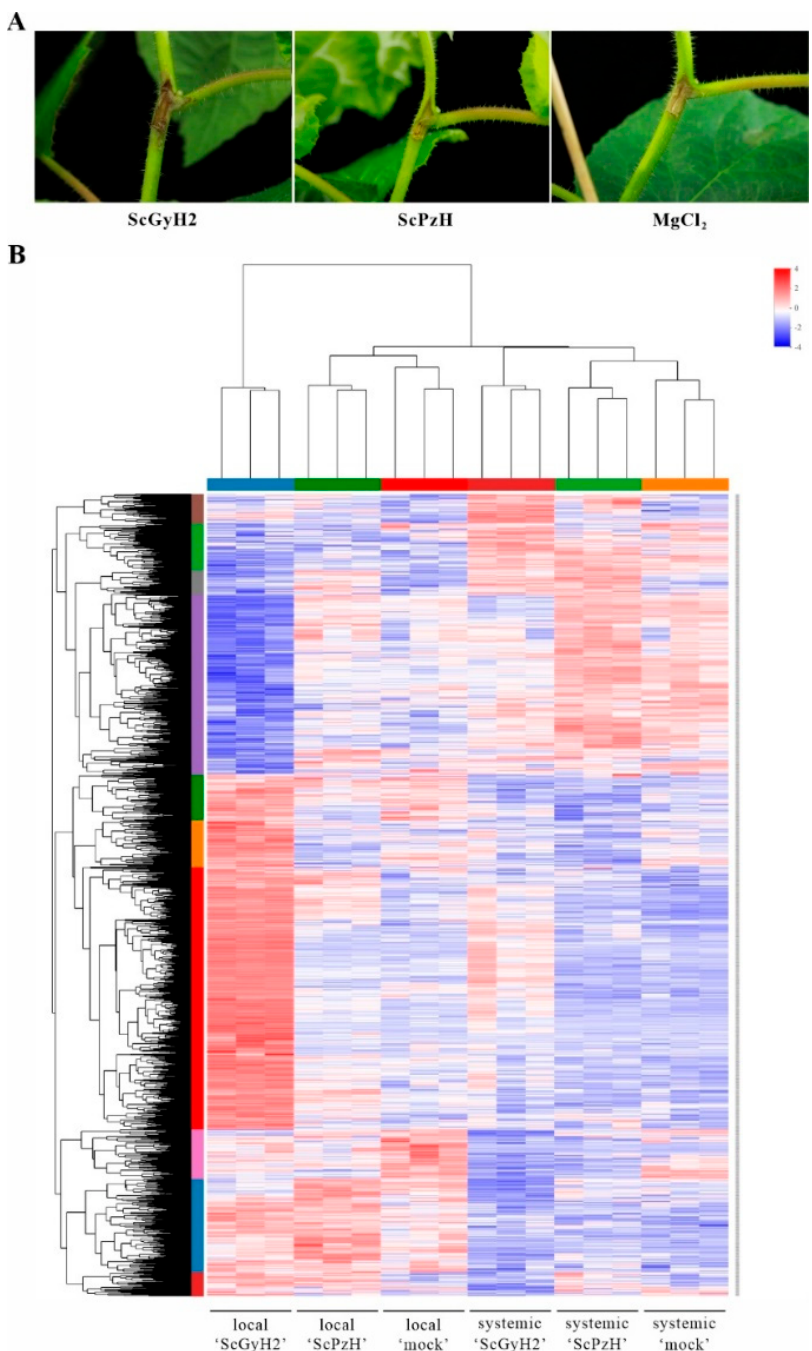
Figure 4. Transcriptomic responses of ‘Hongyang’ to the Psa strains ScPzH and ScPzH. ( A ) Disease symptoms of the Psa inoculated plantlets. Tissue-cultured ‘Hongyang’ were wound-inoculated with 10 9 CFU of ScGyH2 (left), ScPzH (middle), or 10 mM MgCl 2 (right, mock inoculation). All analyses were performed after 14 days. ( B ) Expression heatmap of the unigenes in ScGyH2, ScPzH, or mock- inoculated stem tissues at inoculation sites (local ‘ScGyH2 ′ , local ‘ScPzH, local ‘mock’, respectively) and 2 cm above the inoculation sites (systemic ‘ScGyH2 ′ , systemic ‘ScPzH, systemic ‘mock’). Three biological replicates were included for transcriptomic analysis. The color scale indicates a relative fold-change in expression, where red color shows high expression and blue for low expression.